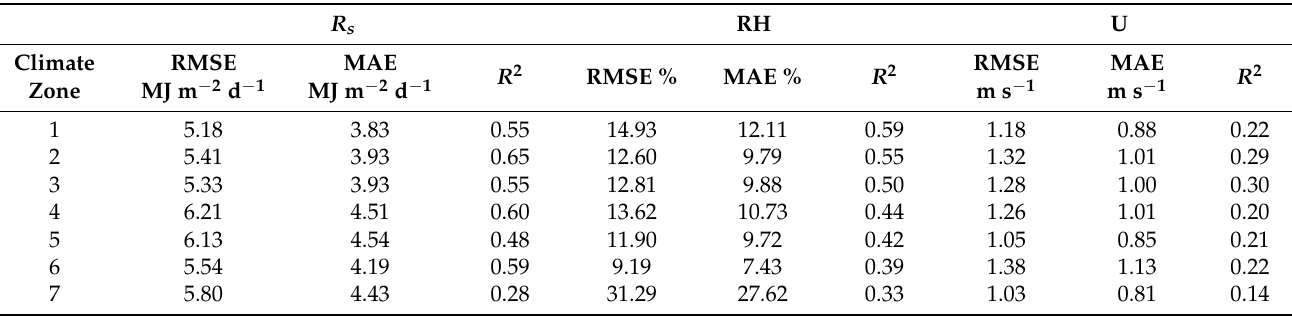
Table 3. Statistical indicators of solar radiation, relative humidity, and wind speed in different climate zones of China. R s RH